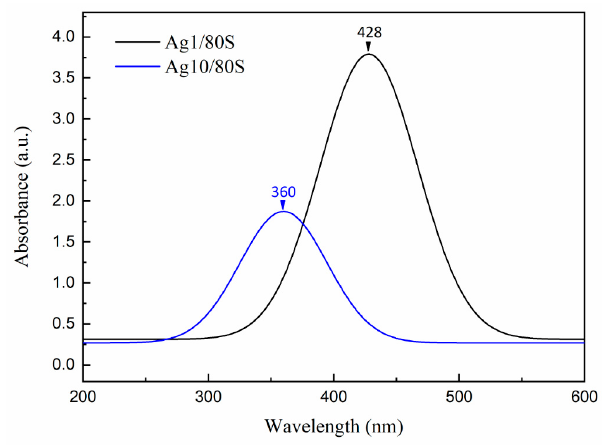
/ 80S; and Ag10 / 80S.